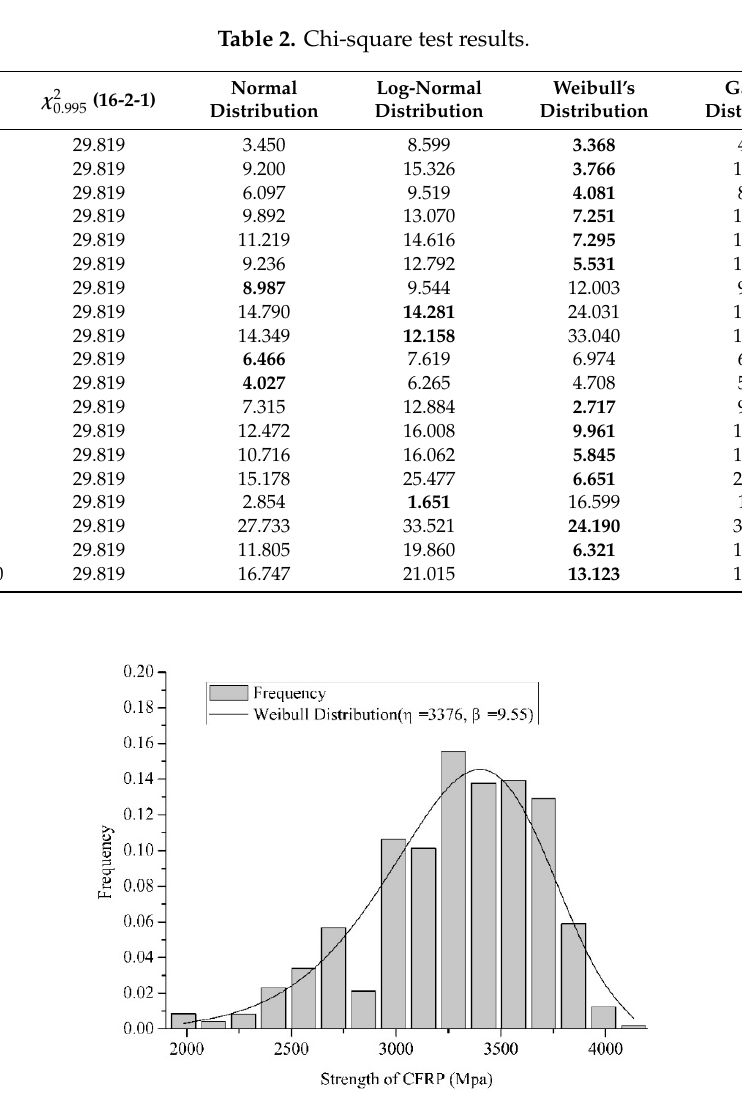
Figure 10. Comparison of the histogram and PDF of the 10-element series system.